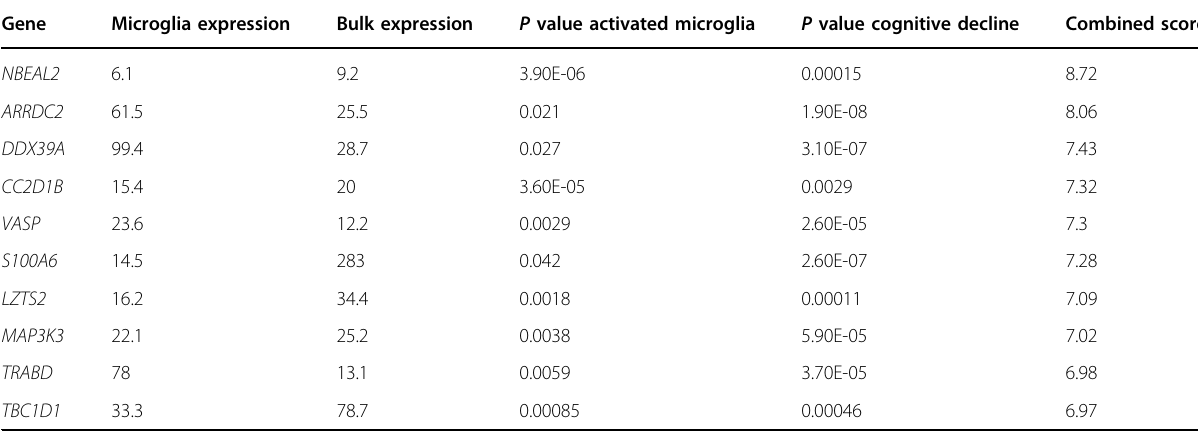
Table 3 Top ten genes in module 5 that are most associated with a combined score for association with activated microglia and cognitive